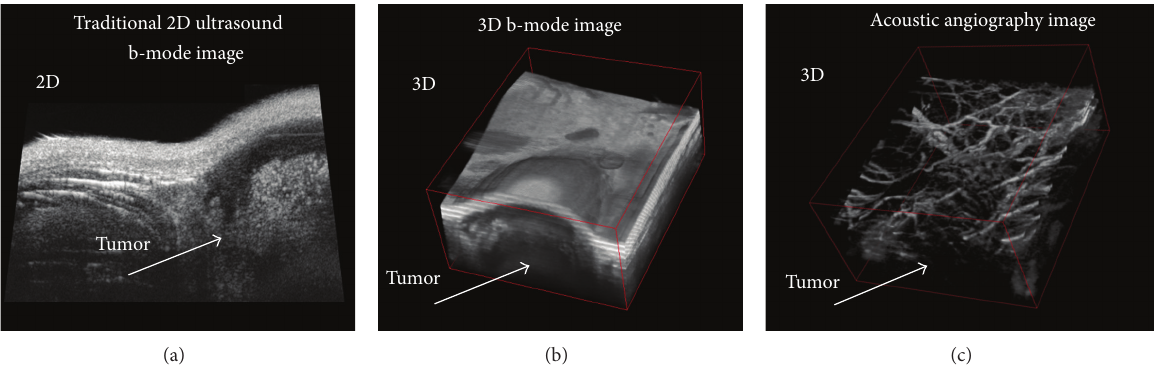
Figure 4: (a) 2D and (b) 3D “b-mode” ultrasound images from the same sample volume illustrating a subcutaneous tumor in a rat. (c) “acoustic angiography” image of the same sample volume as (b) acquired with dual-frequency transducer, illustrating contrast-only image, depicting microvasculature.